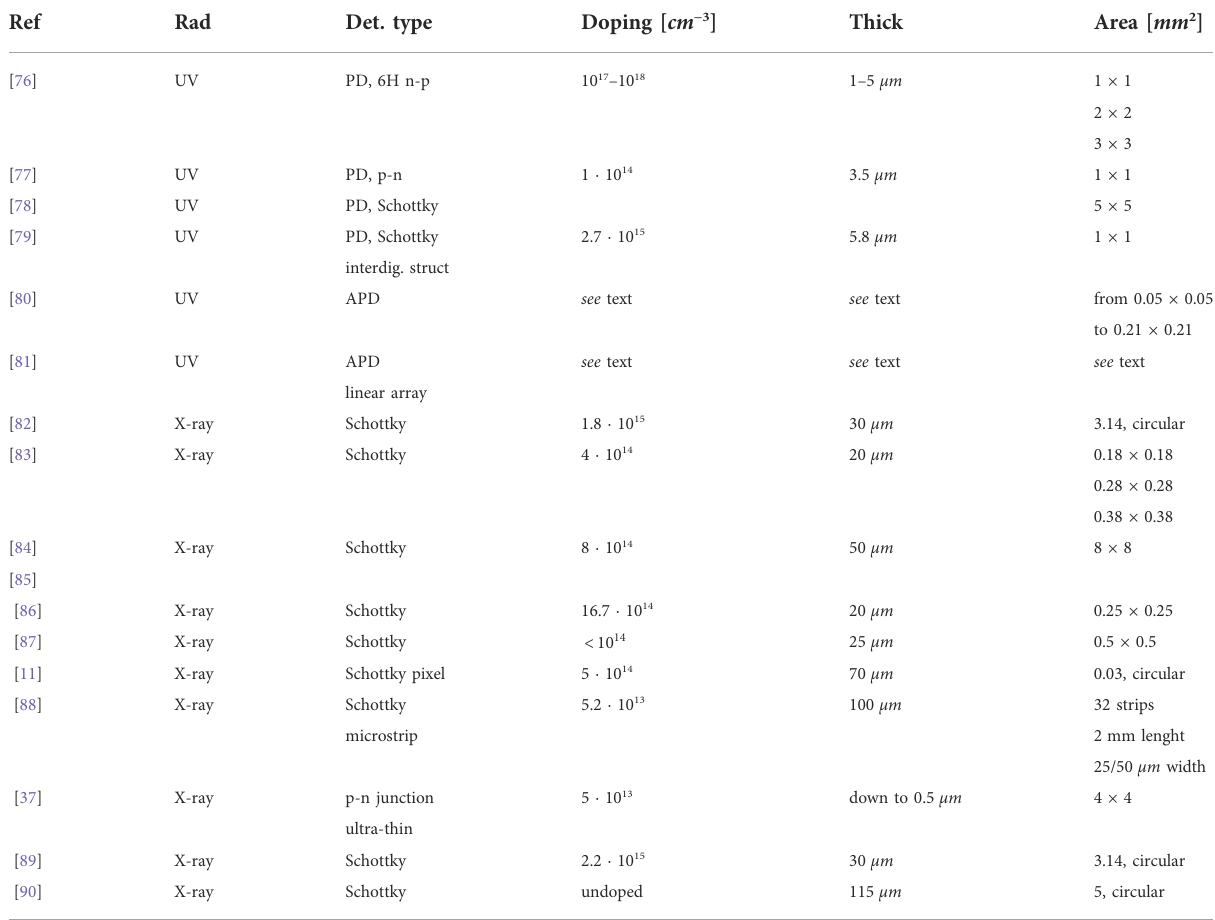
TABLE 3 Properties of the detectors used in the works cited in Par.